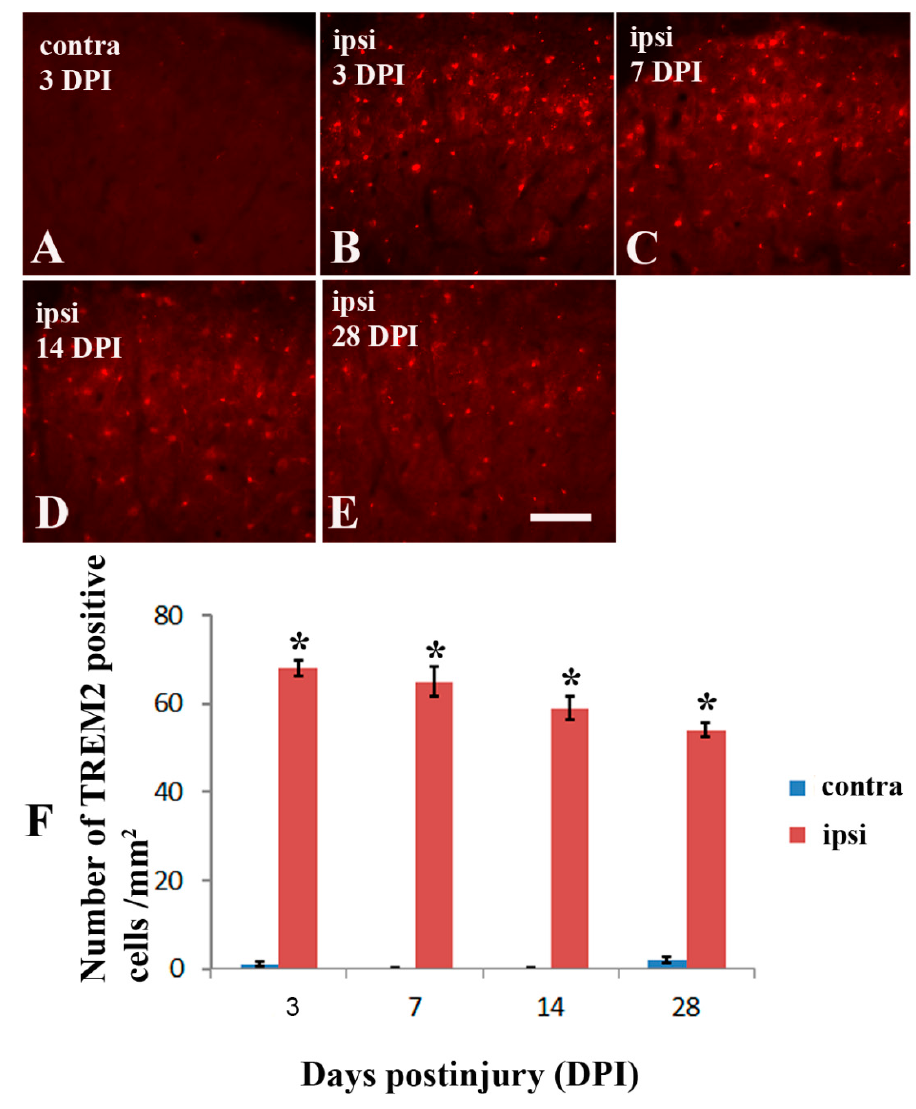
Figure 4. Immunohistochemistry for TREM2 in spinal dorsal horns following nerve ligation of brachial plexus in TgCRND8 mice at the age of 20 months. ( A ): TREM2 expression of the contralateral side (contra) following the nerve ligation. ( B – E ): TREM2 expression of the ipsilateral sides (ipsi) at 3, 7, 14, and 28 days after nerve ligation (DPI). ( F ): Comparison of changes in the TREM2 expression at 3, 7, 14, and 28 days between the contralateral and ipsilateral side of dorsal horn. * Significant differences between the two sides, p < 0.001. Scale bar, 75 µ m.